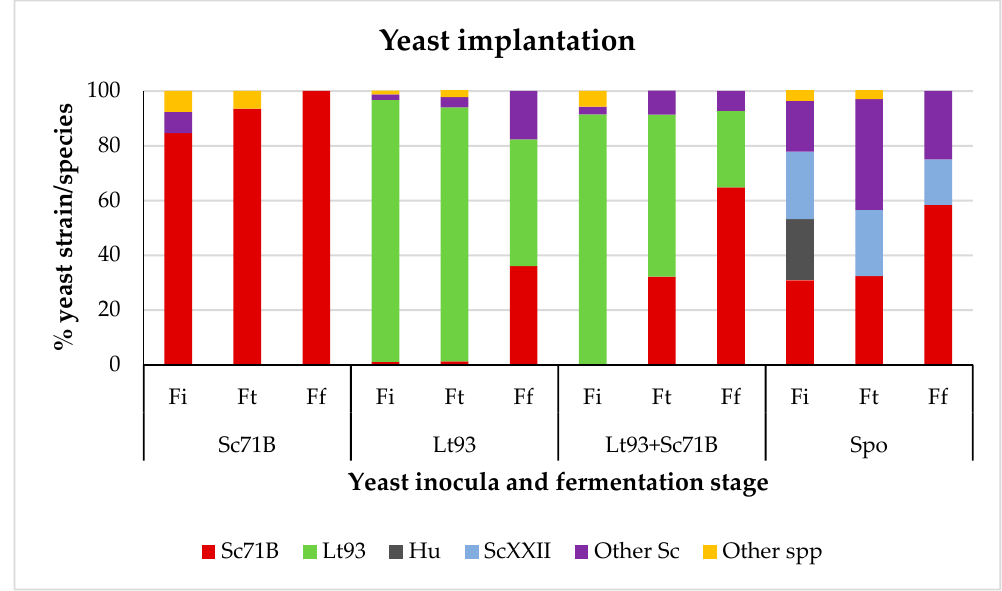
Figure 3 . Evolution of ° Brix and yeast population (CFU/mL) during Mencía fermentations with S. cerevisiae Sc71B and L. thermotolerans Lt93 in monoculture, sequential fermentation (Lt93+Sc71B), and spontaneous process (Spo). m—must; Fi—initial fermentation; Ft—tumultuous fermentation; Ff—final fermentation.